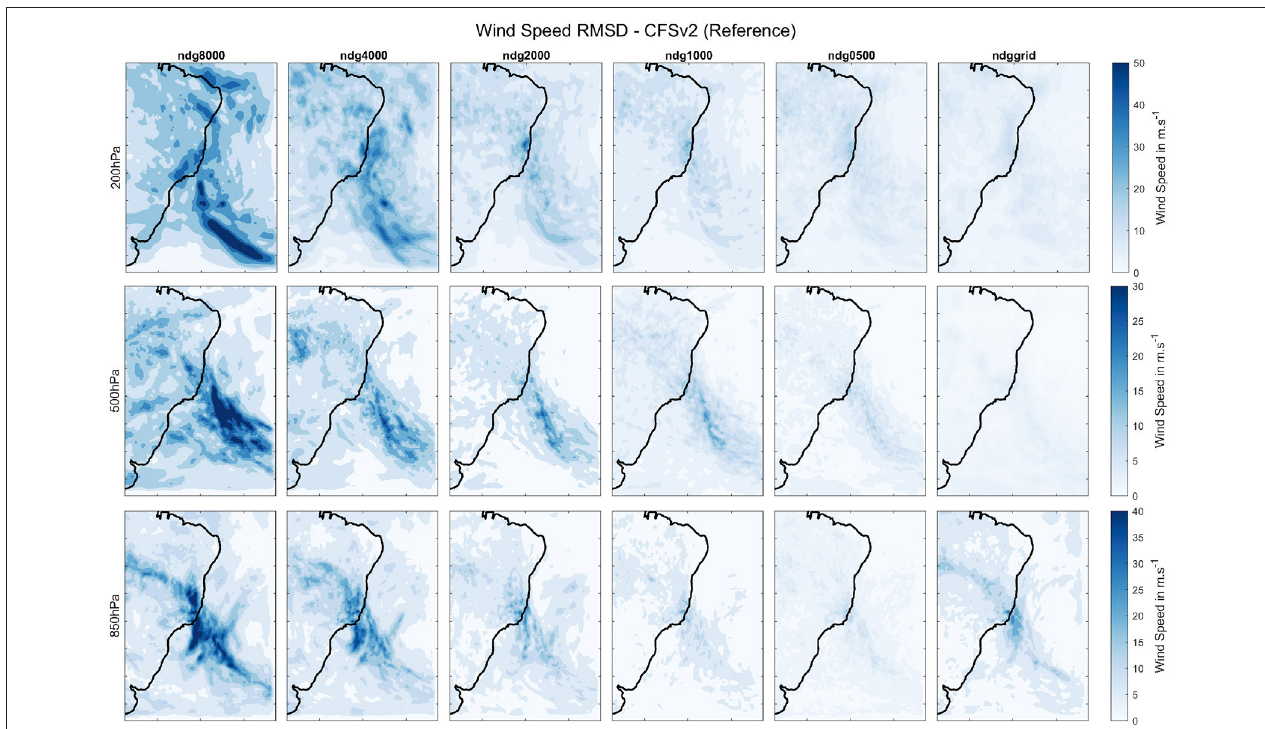
FIGURE 7 | RMSD of wind speed values during the SACZ event. Maps of all numerical experiments (columns) for upper levels (200 hPa, top row), middle levels (500 hPa, middle row) and lower levels (850 hPa, bottom row) are